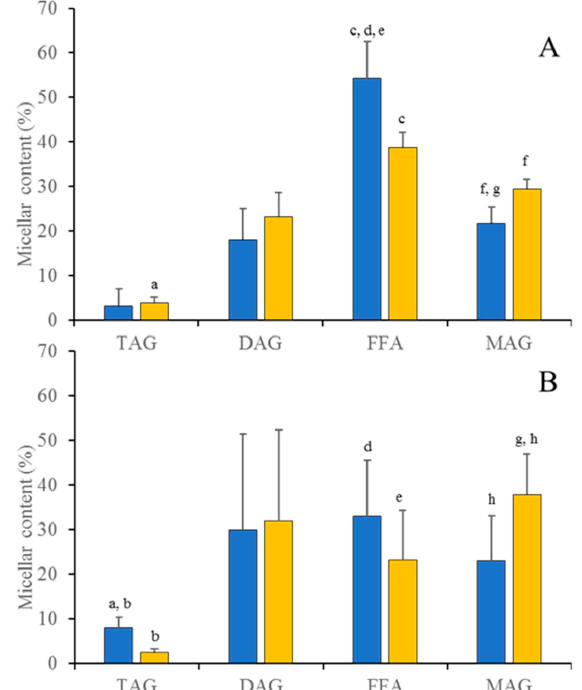
Figure 1. Distribution of the milk acylglycerols in micelles after the application of the in vitro digestion protocol in ( A ) human colostrum and in ( B ) mature milk, (raw sample ■ and pasteurized sample ■ ). Bars represent median values and whiskers stand for standard deviation. Significant differences were observed for each lipid class, independently of the lactation stage and processing stage, and denoted with the same superscript letter. Table 2. p values for the comparison (Mann–Whitney U test) between raw and pasteurized HC and HM samples. Com- parisons are made within each lipid category (triacylglycerols (TAGs), diacylglycerols (DAGs), free fatty acids (FFAs) and monoacylglycerols (MAGs)) value observed in the micellar content.